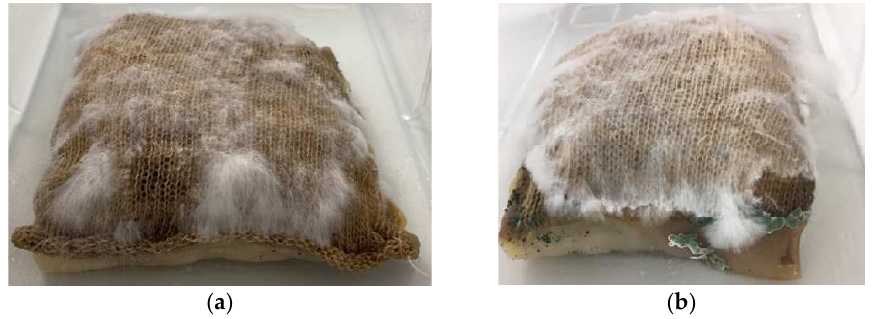
Figure 7. Comparison of experiments 1–3 in the order oven-dried, air-dried, and living from top to bottom in ( a ) wet state and ( b ) dried state (image credit: authors).